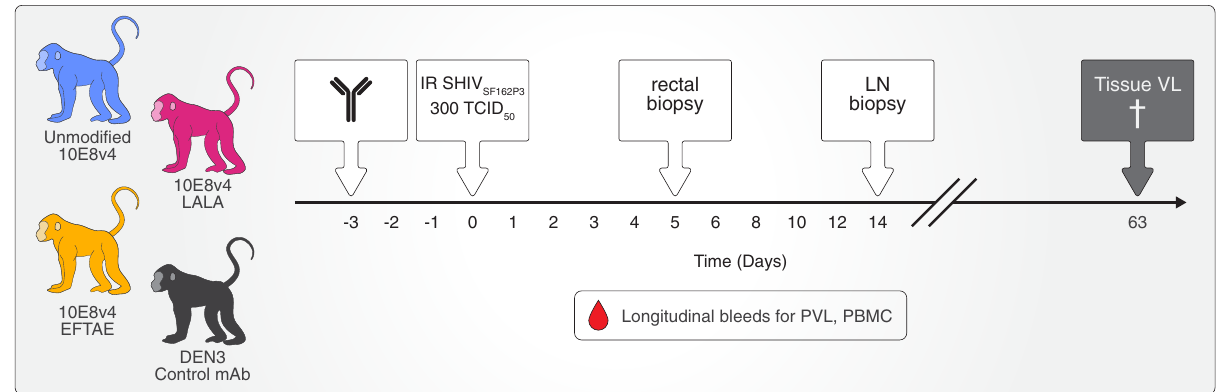
Fig. 3 Schematic of macaque challenge model and tissue sampling. Macaques for challenge studies were divided into four antibody treatment groups, 10E8v4 unmodi fi ed, 10E8v4 LALA, 10E8v4 EFTAE, or isotype control mAb (DEN3). Antibody was subcutaneously delivered 3 days prior to a single high- dose mucosal SHIV SF162P3 challenge. Rectal and inguinal lymph node biopsies were collected on study day 5 and 14, respectively, PBMCs were collected every 14 days, and plasma collected weekly. Thirteen tissues representing diverse anatomical regions, detailed in Fig. 4m, were harvested on study day 63. Group colors are consistent throughout the manuscript. IR intrarectal, TCID 50 50% tissue culture infectious dose, LN lymph node, PVL plasma viral load, PBMC peripheral blood